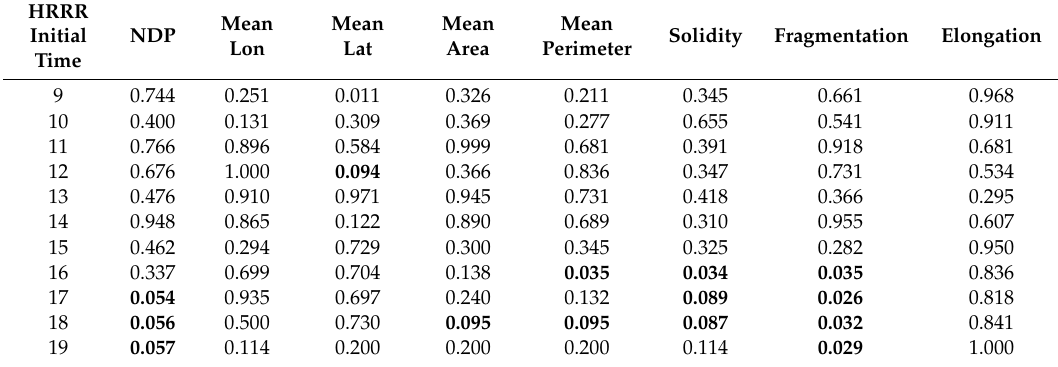
Table 7. Mann–Whitney U p -values for 12.7 mm h − 1 (0.5 in h − 1 ) threshold for 27 May 2018 case. Bold font face indicates significance at 90% confidence threshold.